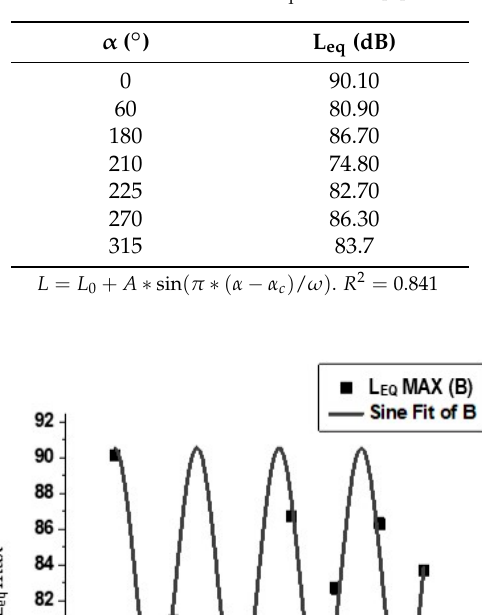
Table 5. Maximum L eq at OS-T [9].